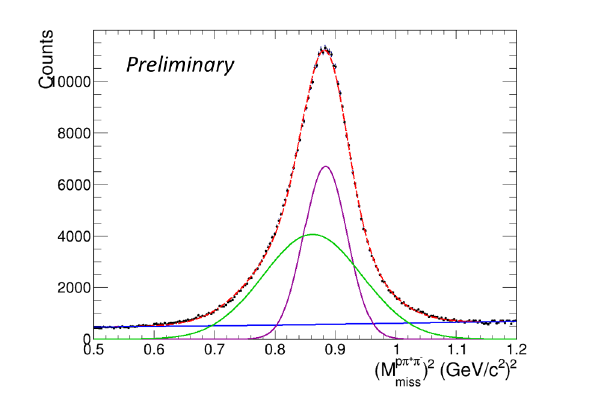
Figure 4. Squared missing mass distribution in the pp → pp π + π − X reaction after subtraction of the three pion production contribution. The red curve represents the result of a fit with the sum of two Gaussians (violet and green curves) and of a polyno- mial (blue curve).